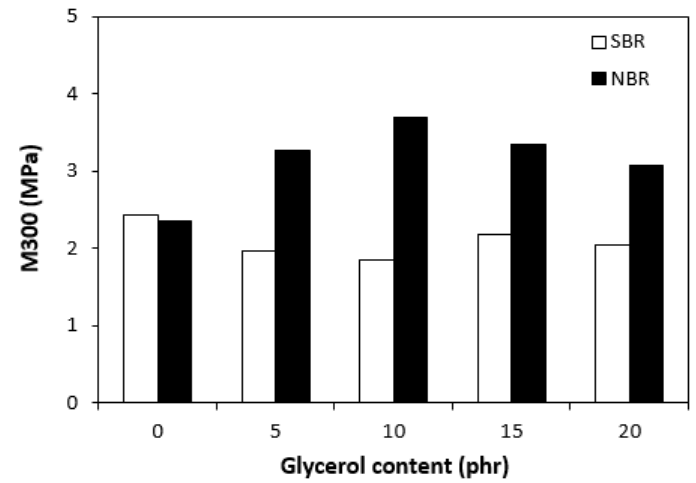
Figure 11. Influence of glycerol content on modulus (M300) of vulcanizates.